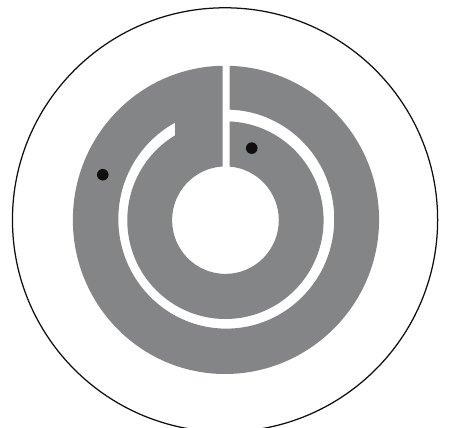
Figure 4: Geometry of the proposed antenna without shorted split ring.